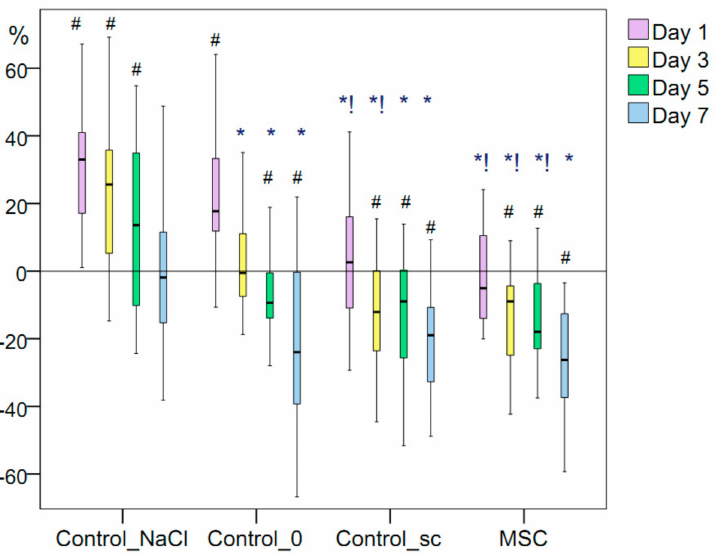
Figure 3. Changes in wound area (%). Note that for the data presented: #, difference in the dynamics of the associated indicator within a particular group relative to day 0 at p < 0.05 (Wilcoxon test); Kruskal–Wallis test: p = 0.0001 on day 1, day 3, day 5 and day 7; *, difference from the Control_T ф C д group at p < 0.05; !, the difference from the Control_T ф C д group at p <